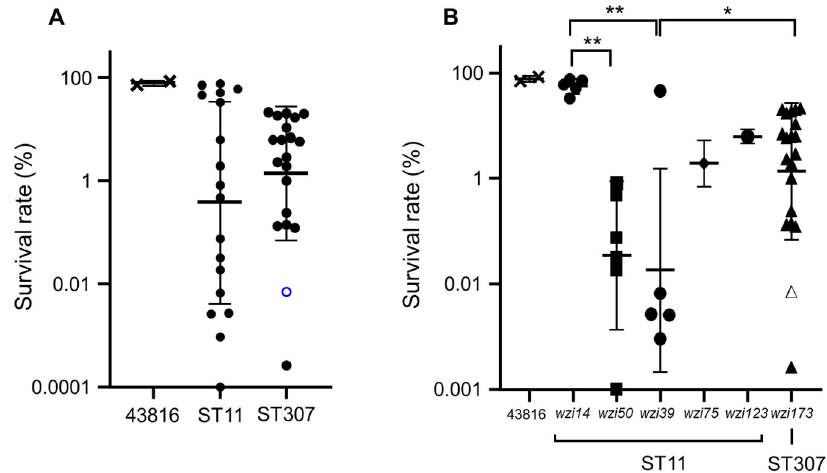
Figure 1. Results of serum resistance assay. ( A ) Survival rates of ST11 and ST307 isolates were compared using Student’s t -test. ( B ) Survival rates were compared among the wzi allele types using analysis of variance (ANOVA) with Bonferroni’s multiple-comparison test. The ( A ) blank circle and ( B ) blank triangle in ST307 represent the survival rate of SCH2106-08, in which a C58T mutation leading to Q20* in the wzi gene was detected. * p < 0.05, ** p < 0.091.